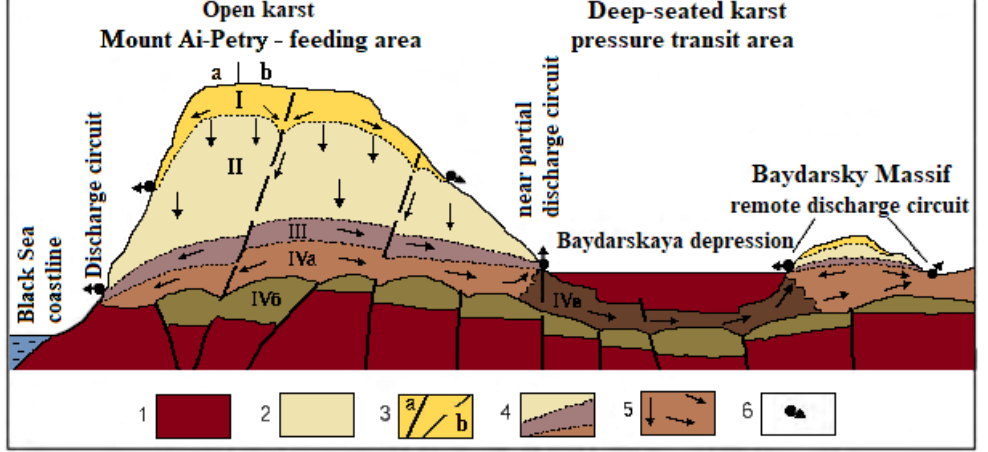
Figure 6. Formation of the groundwater flows at the southwest of the Crimean Peninsula. Adopted